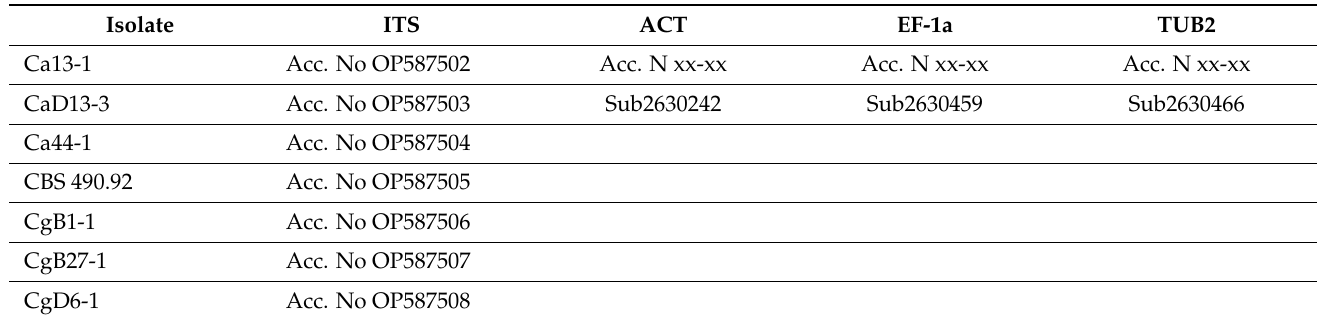
Table A1. NCBI accession numbers of the DNA sequences identified in the current